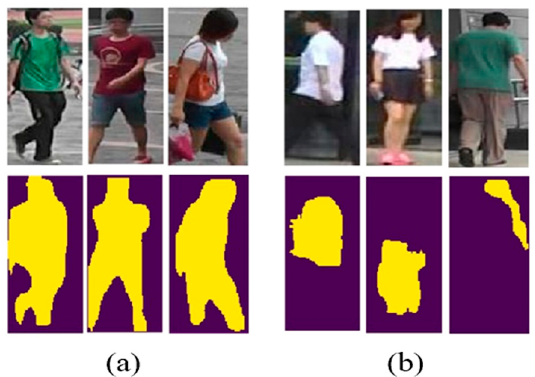
Figure 2. Some results of segmentation masks: ( a ) Complete; and ( b ) incomplete. The top row denotes original images, with corresponding binary masks below, where body regions display in yellow pixels.